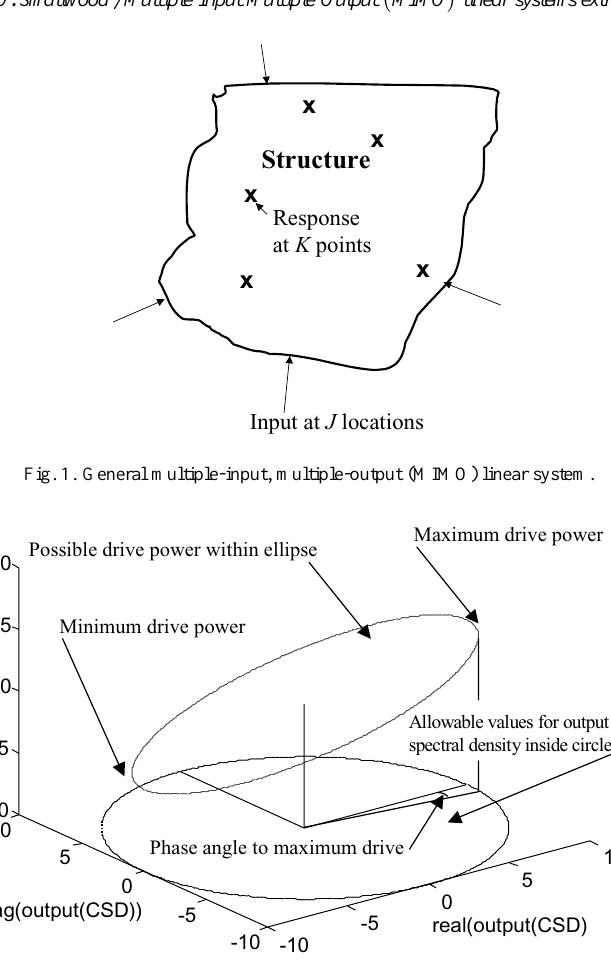
Fig. 2. Geometric interpretation of input